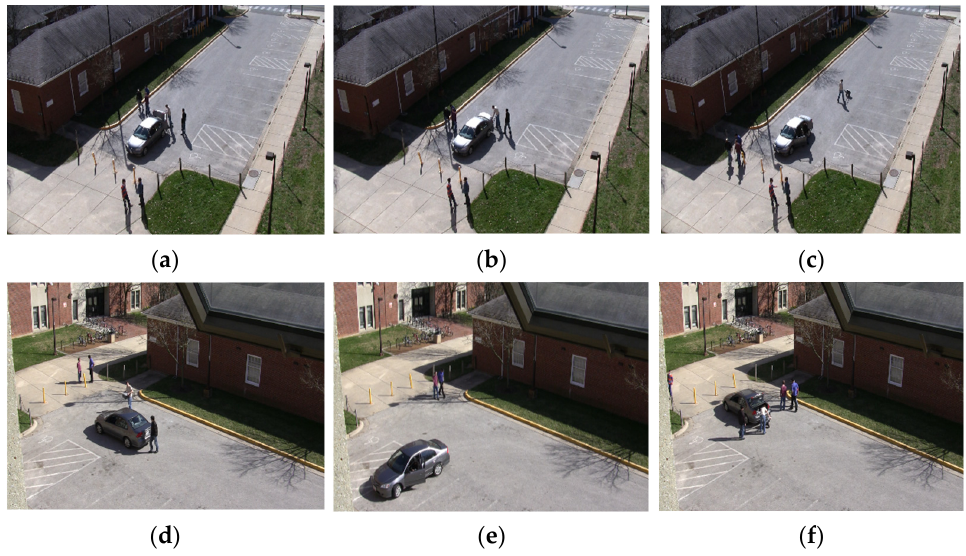
Figure 12. A few samples of the VIRAT Video dataset, including ( a ) opening trunk, ( b ) closing trunk, ( c ) entering into vehicle, ( d ) carrying an object, ( e ) getting out of vehicle, and ( f ) loading an object.